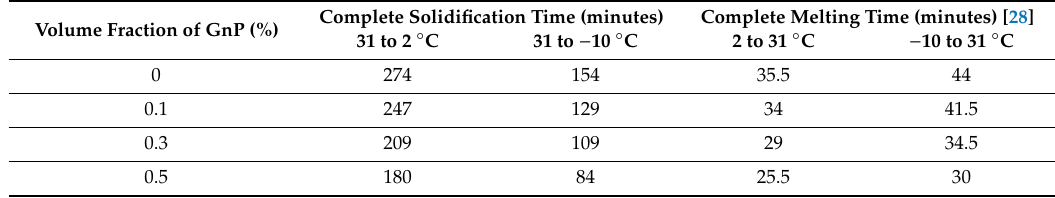
Table 3. Comparison of complete solidification and melting timing of PCM nanocomposite for various GnP